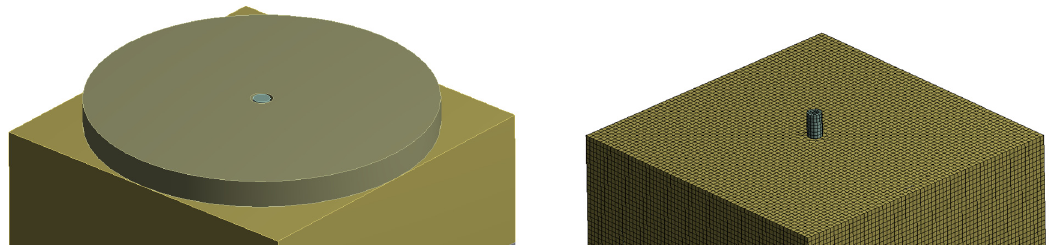
Figure 9. Simulation set-up. Prescribed deformation was applied on the anchor, upwards.